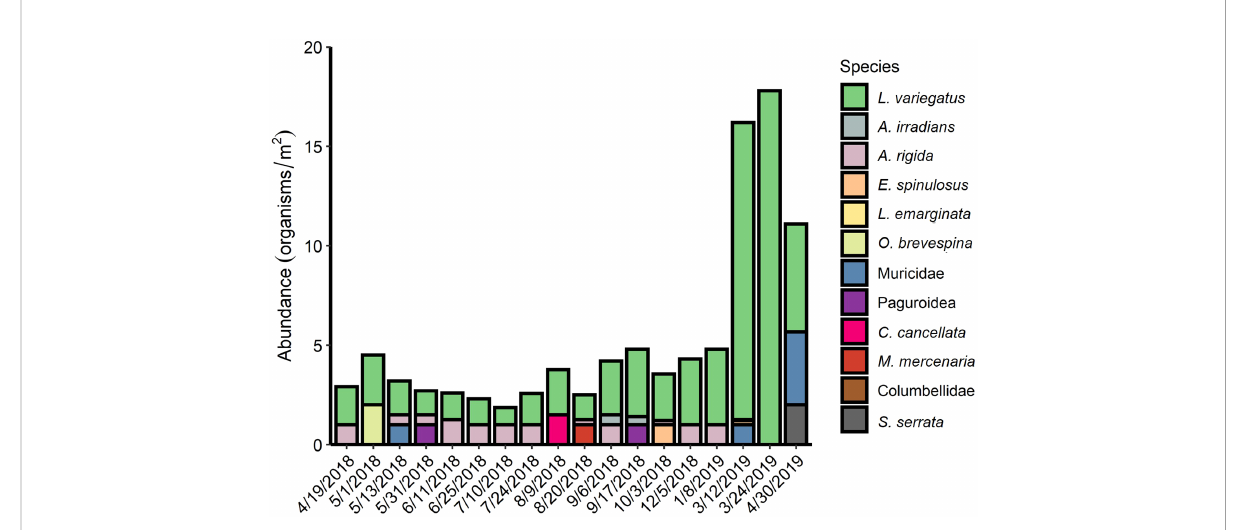
FIGURE 3 Macroinvertebrate survey results throughout the experimental period. The dates along the x-axis represent the dates surveys took